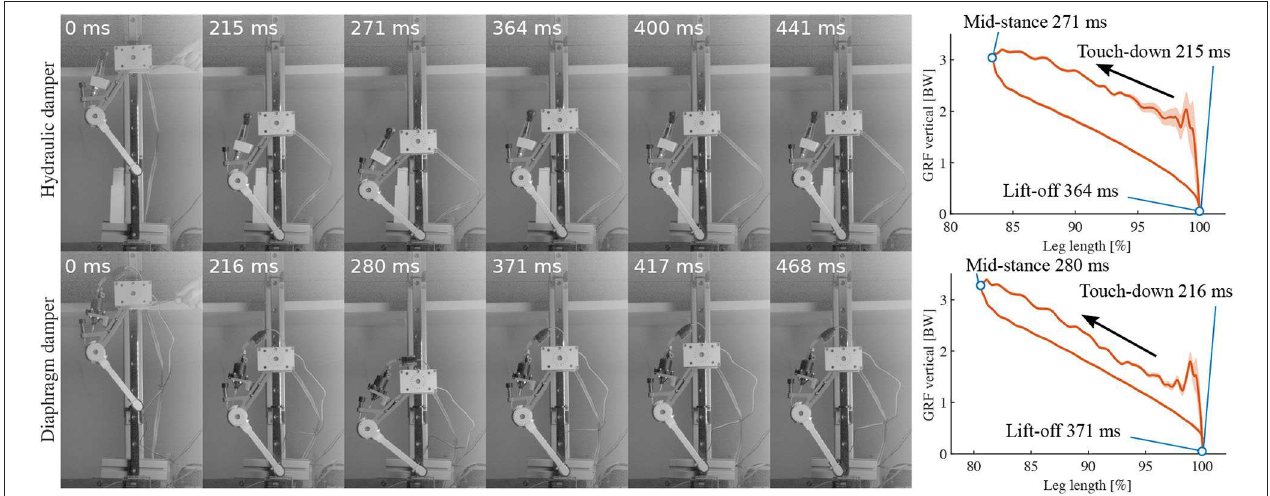
FIGURE 6 | High-speed snapshots of drop experiments starting from release to second touchdown. Leg with hydraulic damper is shown on the top row, leg with diaphragm damper the bottom row. Depicted are from left to right: release, touchdown, mid-stance, lift-off, apex, second touchdown. The right plots illustrate the timing of the events corresponding to the snapshots.